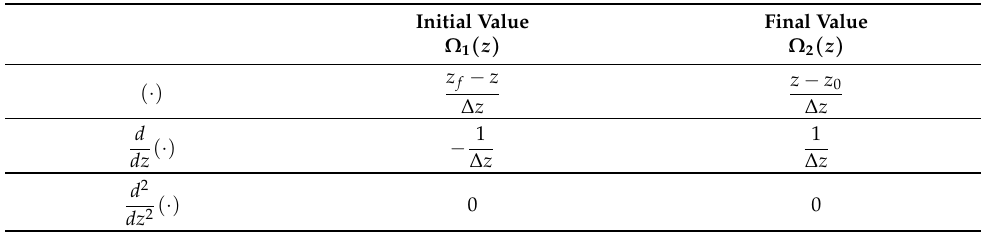
Table A3. Switching functions for a two constraints constrained expression, with both constrains on f , defined on domain of z ∈ [ z 0 , z f ] .